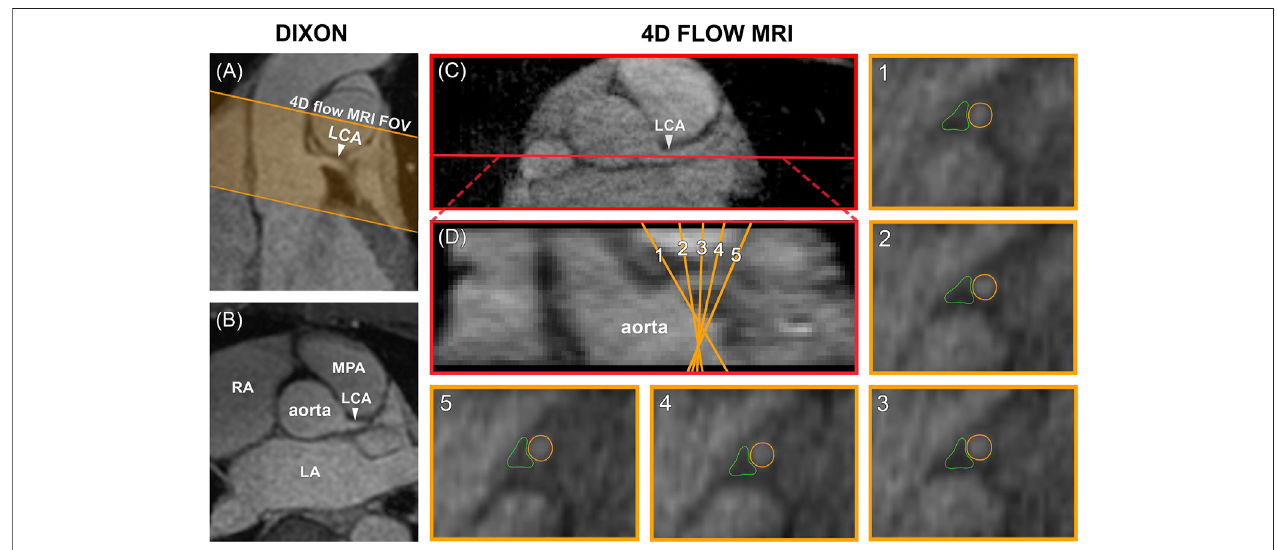
FIGURE2|(A) Planningofthe4D fl owMRI fi eldofview(orange)ontheDixonwaterimage. (B) TransversalviewoftheDixonwaterimage. (C) TheLCAisidenti fi ed onatransversal4D fl owMRImagnitudeimageandalongitudinalcross-sectionismade(showninred). (D) Theresultingcoronalviewisusedtoplace fi veanalysisplanes perpendicular to the LCA. 1 – 5) In these planes, measurement contours are placed around the LCA lumen and in adjacent pericardial fat. FOV (cid:1) fi eld of view, LCA (cid:1) left coronary artery, LA (cid:1) left atrium, RA (cid:1) right atrium, MPA (cid:1) main pulmonary